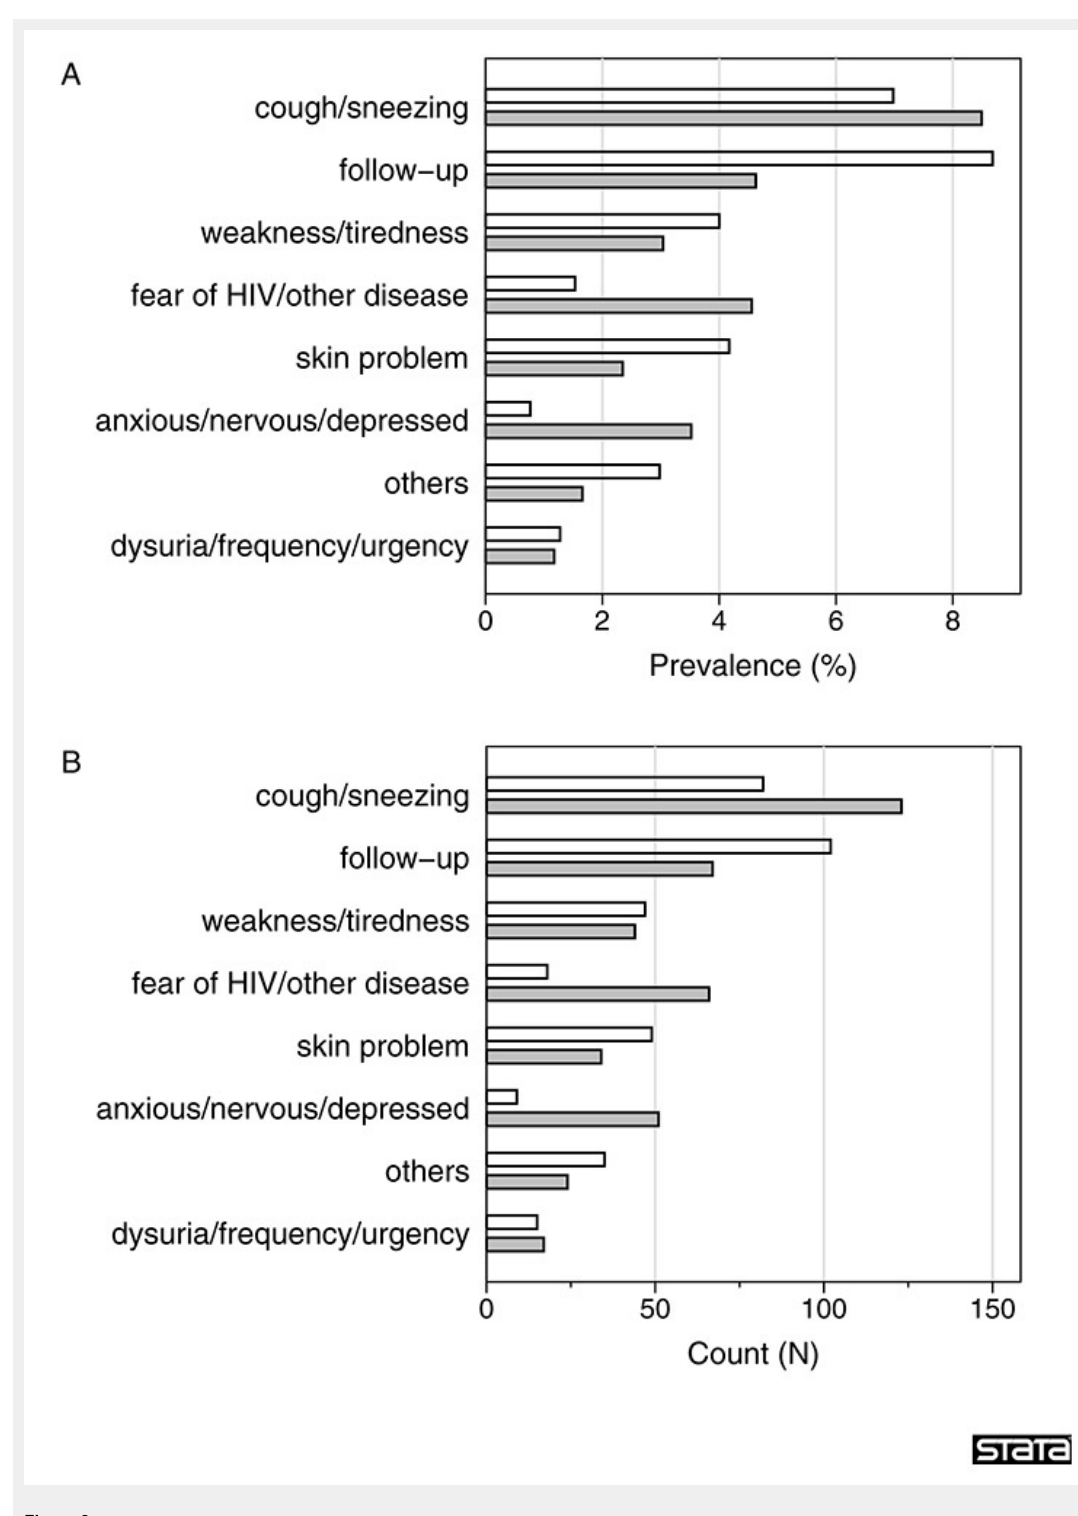
Figure 2 Prevalence rates and counts of “non-urgent” encounters stratified by the observation period. Based on the ICPC-2 codes, we defined “non-urgent” encounters and categorised them as presented. The prevalence rates (panel A) and counts (panel B) are provided separately for the observation period 1 January to 31 January 2008, inclusive (white bars), and 1 January to 31 January 2009, inclusive (grey